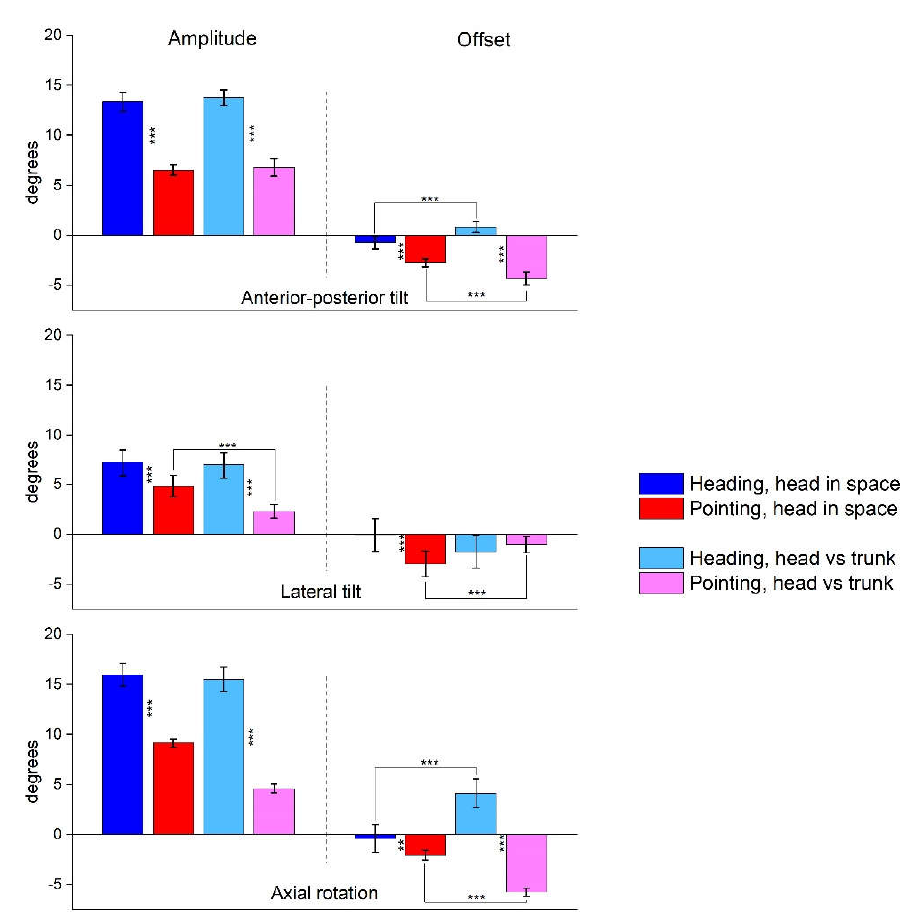
Figure 4. Variation of the parameters of the sinusoidal fitting. The graphs show the amplitude and offset of the sinusoidal fitting of the Euler angles as a function of target direction. Each histogram represents the mean ± SEM of 10 participants. Asterisks indicate statistical significance calculated by the fitting procedure (Origin Software, Levenberg Marquardt algorithm). Black asterisks vertically oriented compare tasks (pointing vs heading) and asterisks horizontally oriented compare reference frames (head orientation by reference to trunk vs space) (***: p < 0.001, **: p < 0.01, *: p < 0.05).